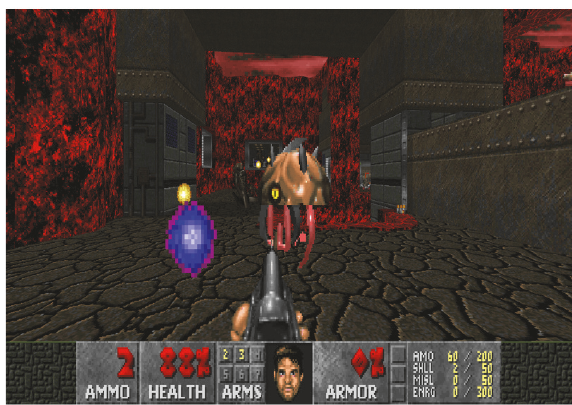
Figure 1: A sample screen from Doom showing the first-person